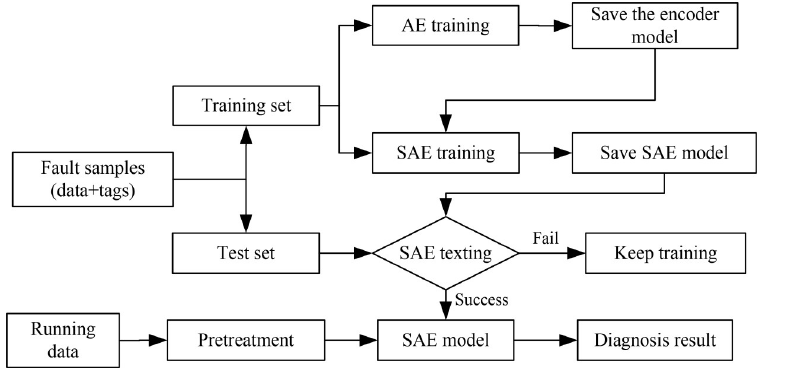
Fig 11. Structure of SAE diagnostic